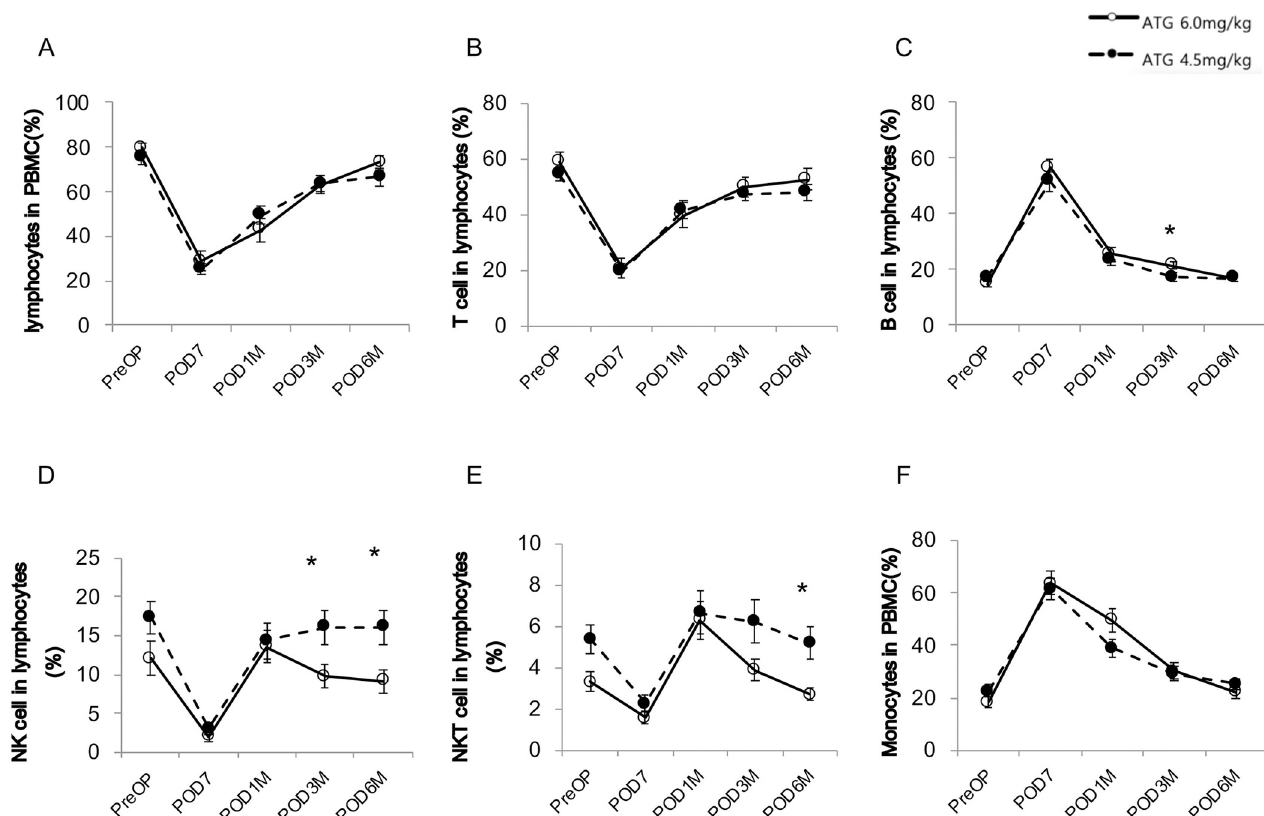
Fig 3. Changes in the proportions of immune cell populations. Total lymphocytes (A), T cells (B), B cells (C), NK cells (D), NKT cells (E), and monocytes (F) during follow-up after kidney transplantation are shown according to the dosage of ATG.